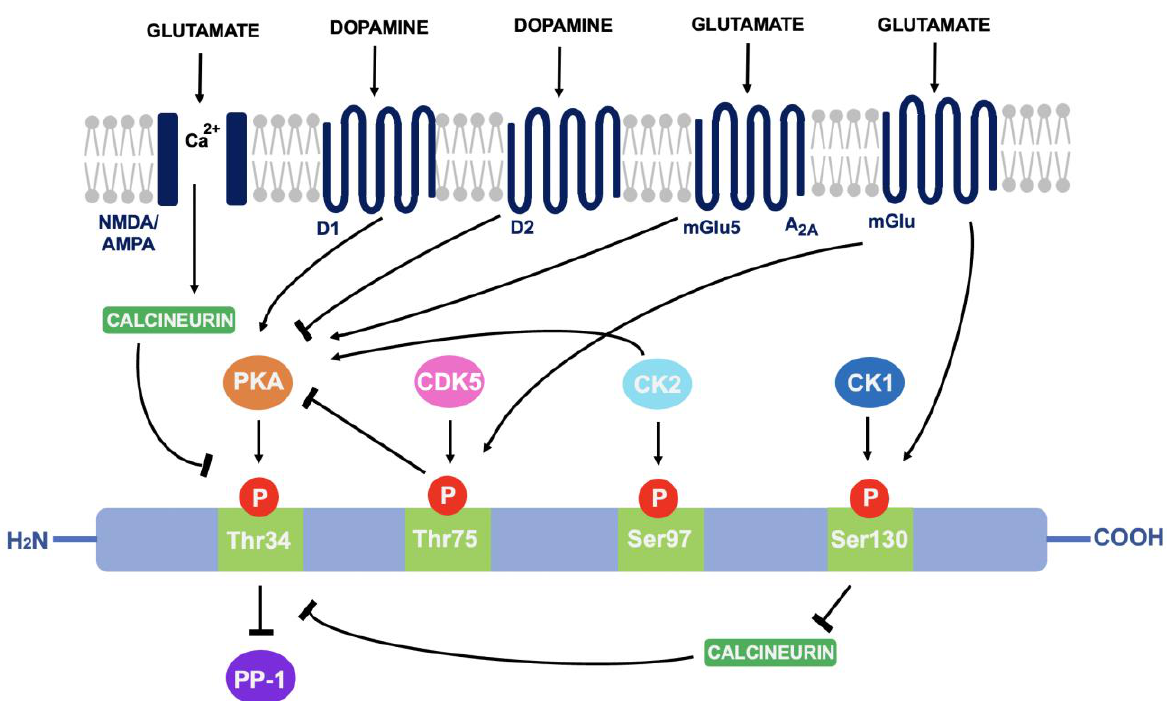
Figure 3. A summary of the actions of dopamine and glutamate on DARPP-32 phosphorylation: Through phosphorylation of DARPP-32 at four main amino acid sites (Thr 34 , Thr 75 , Ser 97 and Ser 130 ), DARPP-32 acts as either a PP-1 or PKA inhibitor.